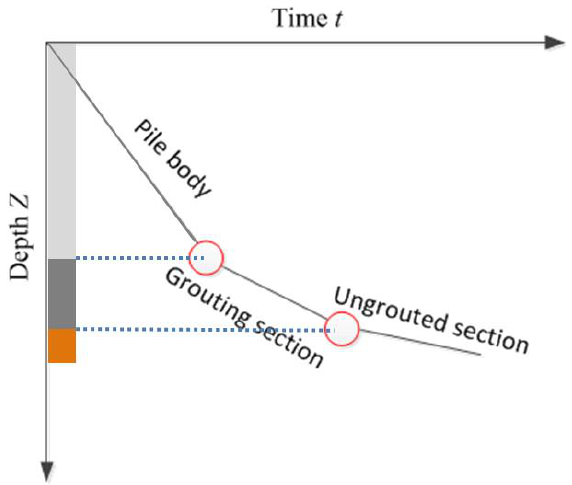
Figure 4. Detection principle of the transmitted wave method in the pile.